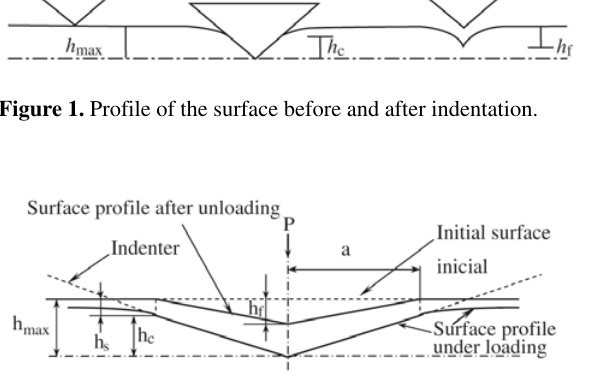
Figure 2. Main parameters used in analyzing unloading vs. indenter depth curves.